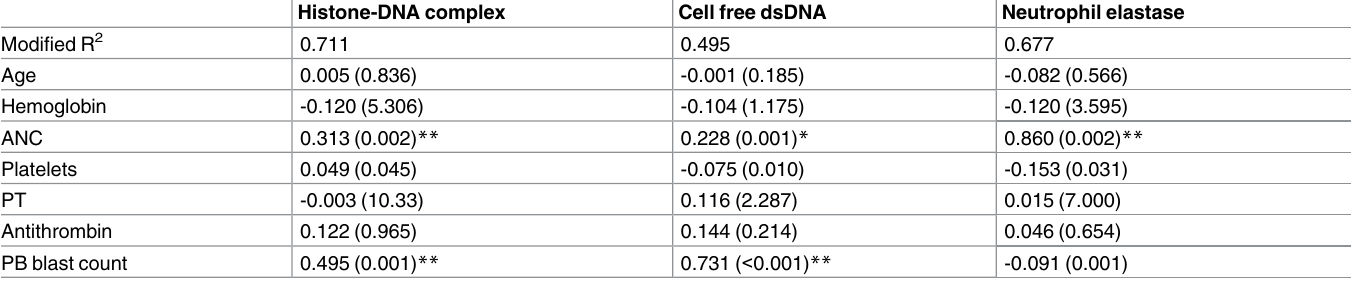
Table 2. Multiple regression analyses for determination of contributing factors to histone-DNA complex, cell free dsDNA and neutrophil elastase levels in